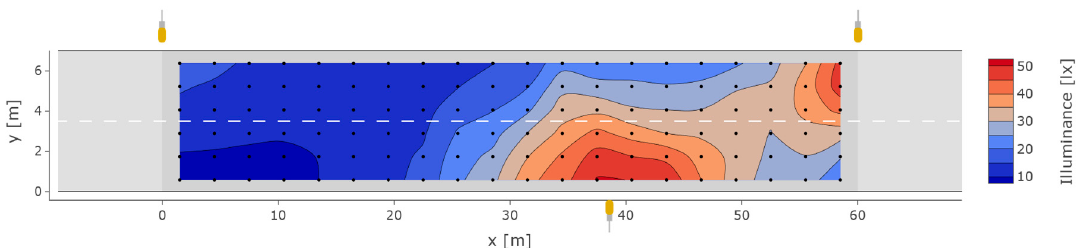
Figure 5. Position of the luminaires on the roadway and experimental illuminance. Black dots show the distribution of the points at which measurements were taken.